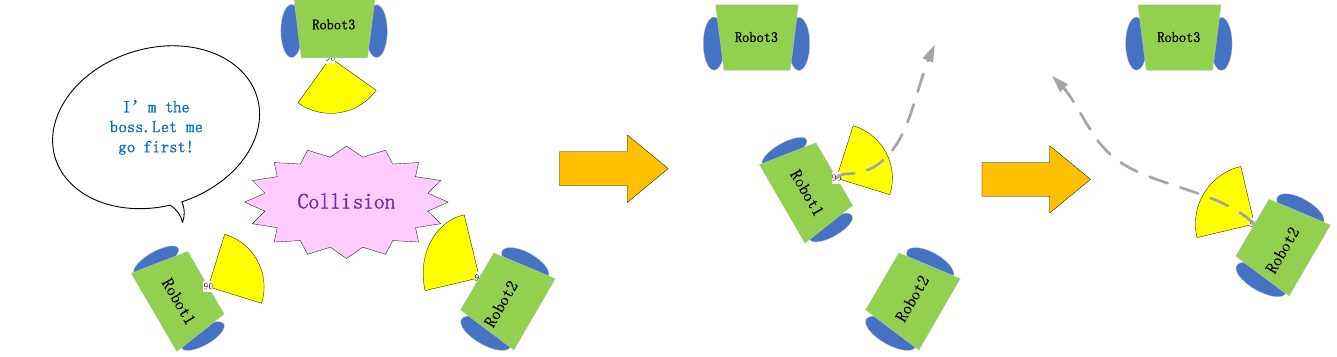
Figure 11. Schematic diagram of multiple mobile robot encounters.